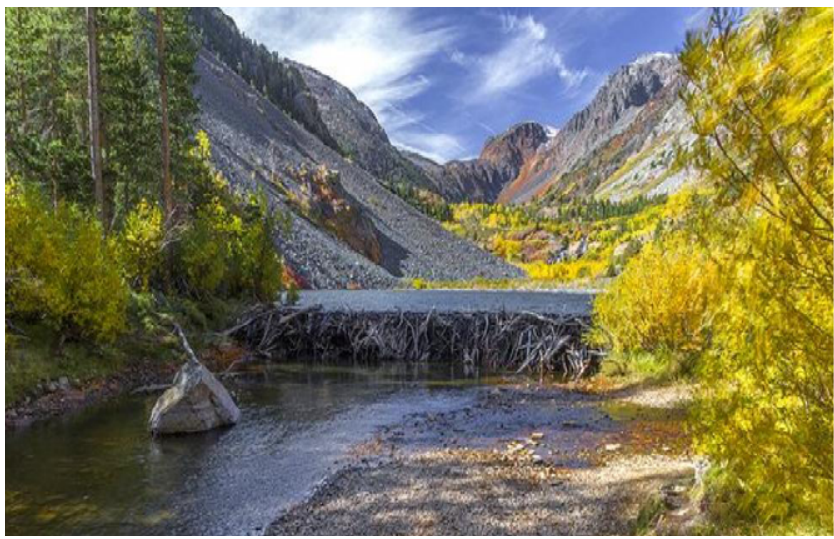
Beaver dam above Lundy Lake, California © Fred Moore [https://theecologist.